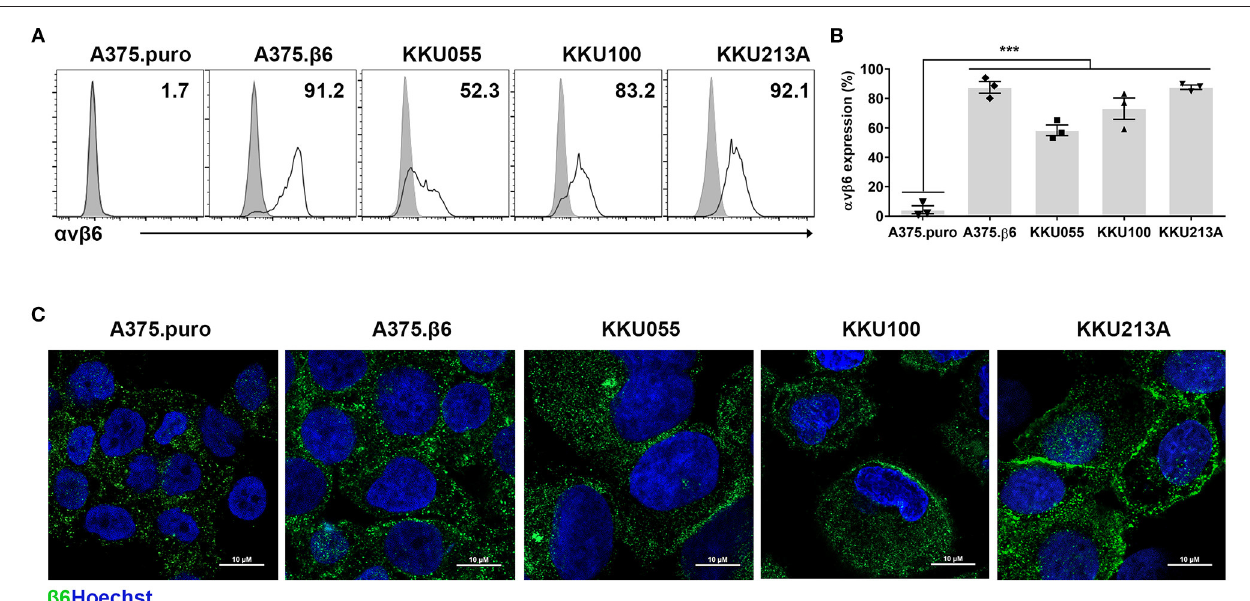
FIGURE 2 | Expression of integrin α v β 6 on cholangiocarcinoma (CCA) cell lines. (A) Integrin α v β 6 was stained with anti-integrin α v β 6 mAb in the indicated CCA cell lines and analyzed by flow cytometry. A representative result of flow cytometry analysis demonstrates CCA cell lines stained with isotype-control antibody (gray peaks), and CCA cell lines stained with anti-integrin α v β 6 mAb (white peaks). (B) A quantification bar-graph summarizes the data from 3 independent experiments (*** p < 0.001). The data with error bar represent mean ± standard error of mean (SEM). Differences between the group of β 6-negative A375.puro cells and those of cell lines with positive expression of integrin α v β 6 were analyzed by one-way analysis of variance (ANOVA). (C) Immunofluorescence images of CCA cell lines show membranous and granular expression of integrin β 6 stained with anti- β 6 polyclonal antibody (green) and nuclei staining (Hoechst 33342; blue), and A375. β 6 was used as a positive control. Scale bars represent 10 µ